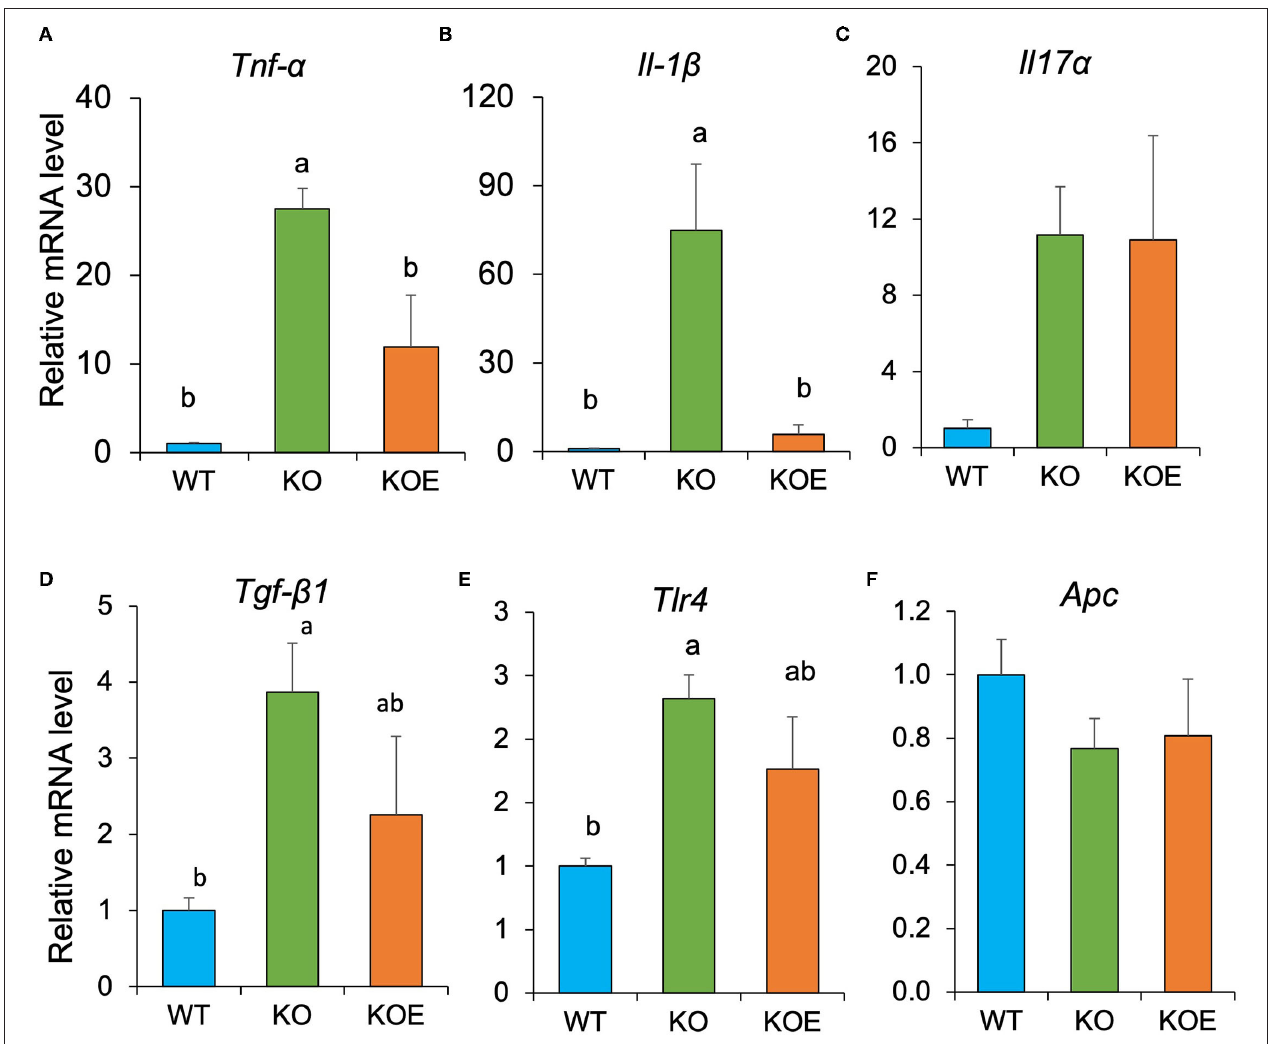
FIGURE 5 | Eggshell membrane (ESM) modulates relative gene expression of several proinflammatory cytokines relative to RPLP1 in the mouse colonic mucosa. After the 19-week treatment, relative mRNA expression of Tnf- α (A) , Il1 β (B) , Il17a (C) , Tgf- β 1 (D) , Tlr4 (E) , and Apc (F) in colonic mucosa were examined